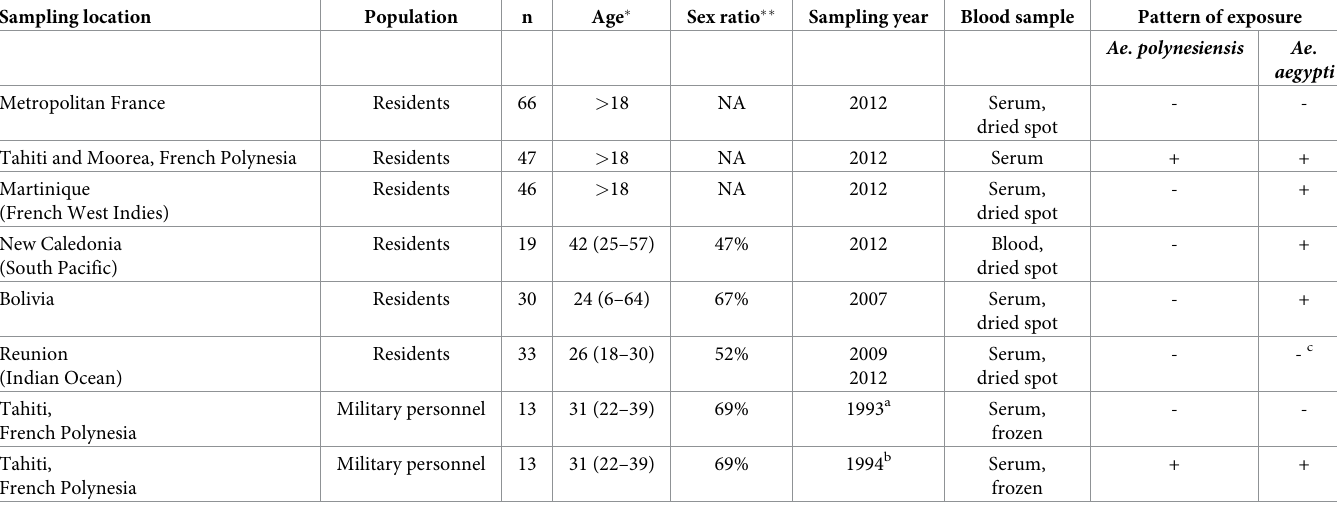
Table 1. Characteristics of the populations under study. Sampling